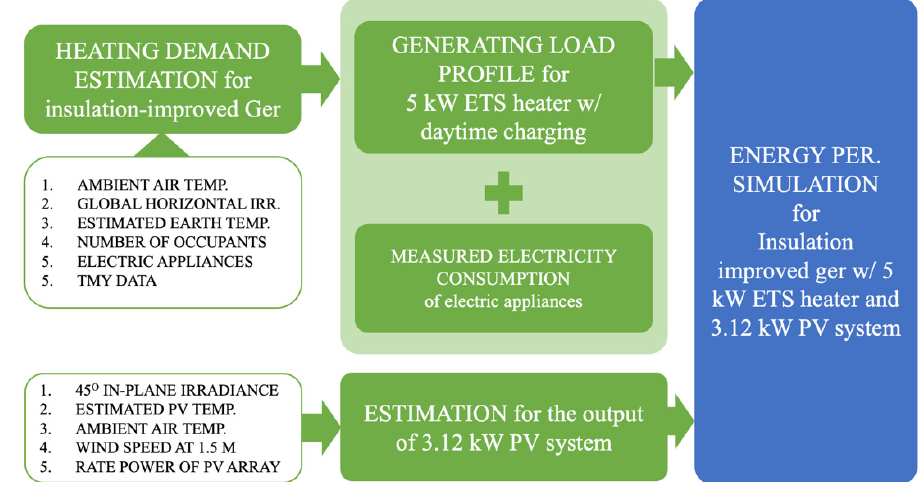
Figure 3. The flow chart of the energy performance simulation.